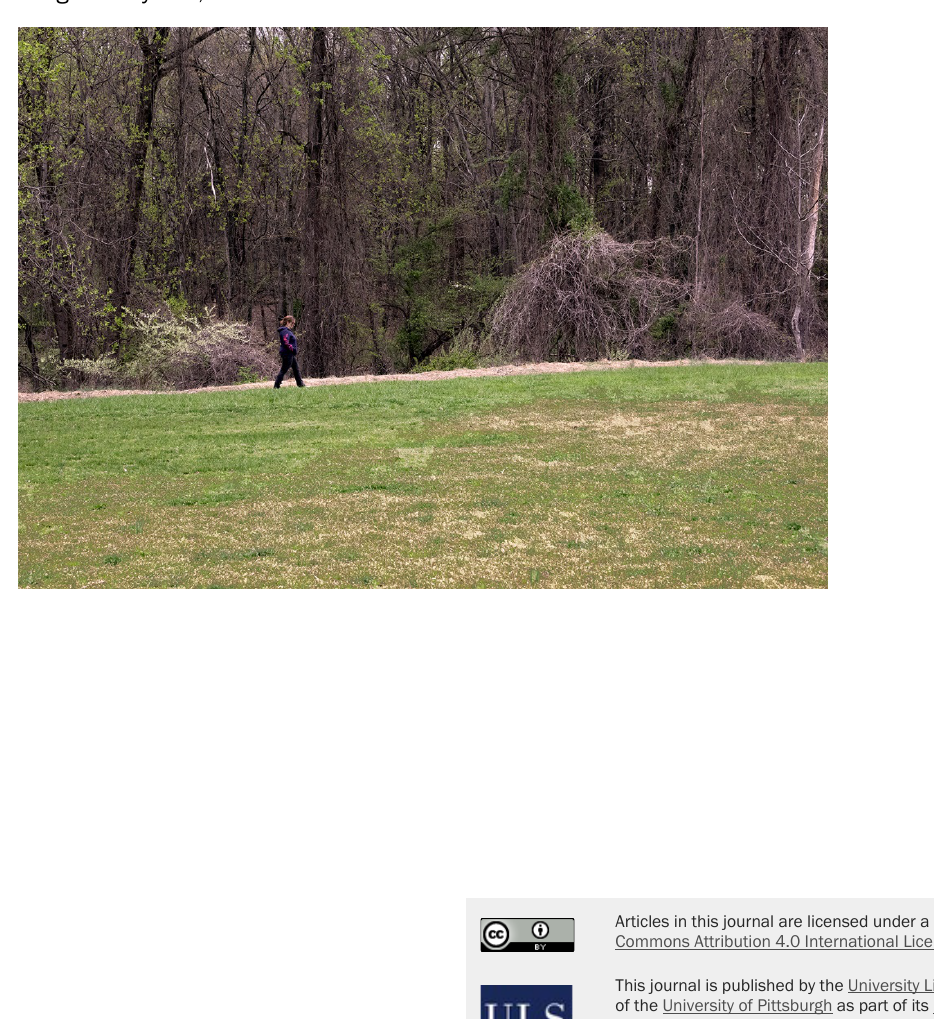
Figure 2 Social distancing in Maryland, 2020